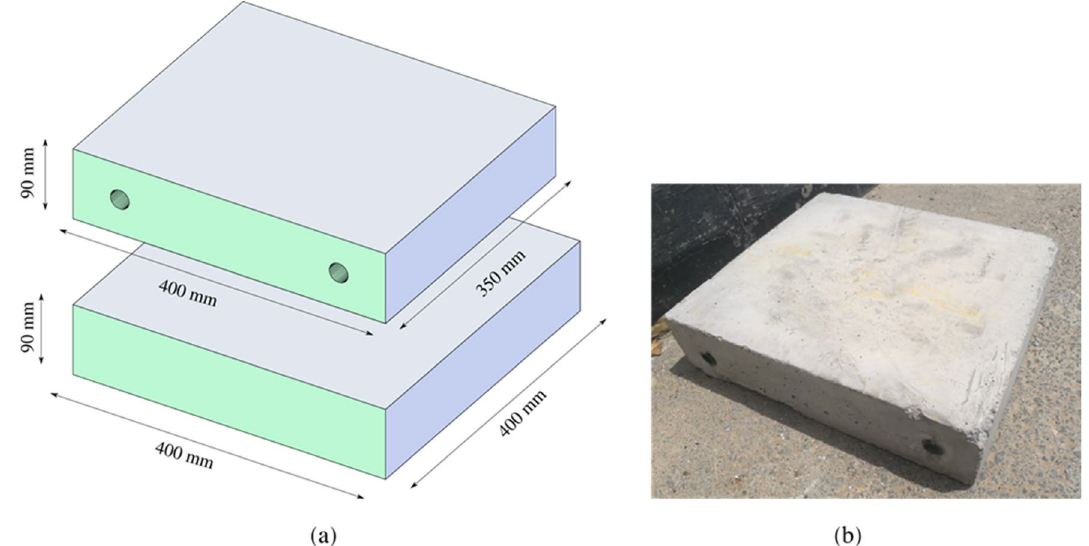
Figure 2. ( a ) Dimensions of test specimens and ( b ) concrete top block